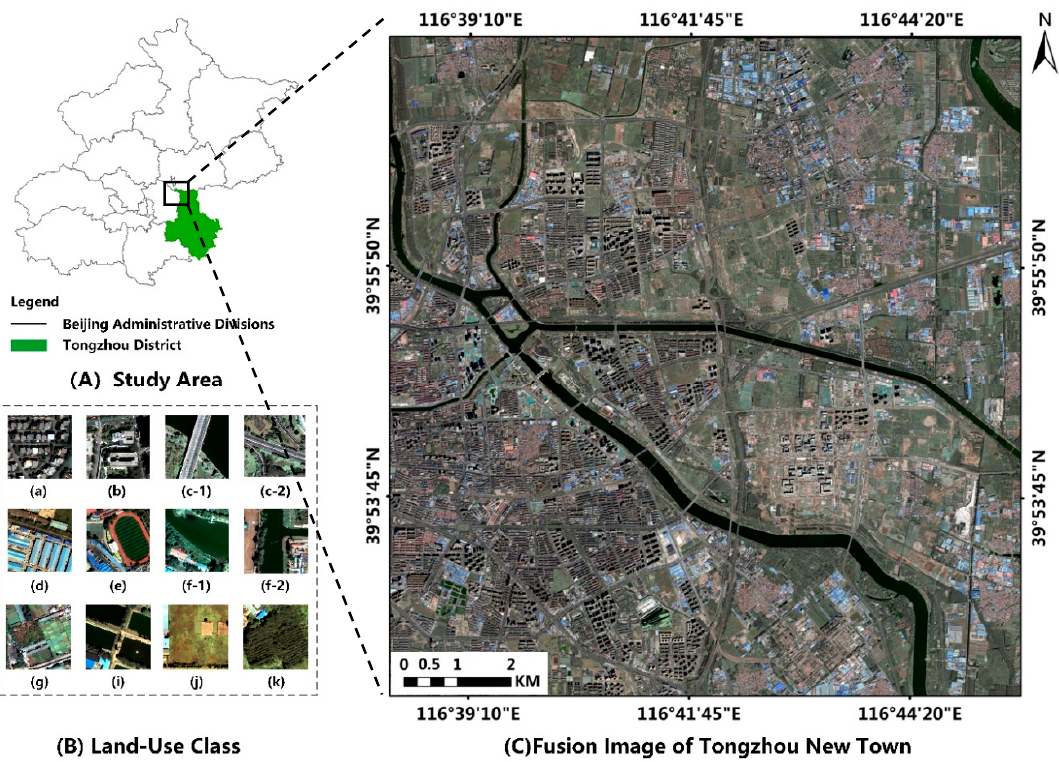
Figure 3. Experiment data ( A ) overview of the study area, ( B ) samples of land-use class: (a) residential, (b) commercial, (c) infrastructure, (d)industrial, (e) playground, (f) water, (g) farmland, (i) breeding, (j) unused land, (k) woodland and ( C ) Tongzhou New Town image fused by principal component substitution (PCS).